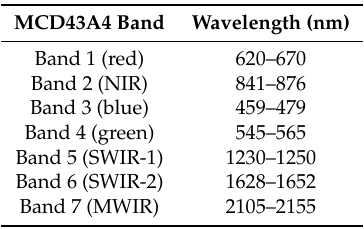
Table 1. Spectral specifications of the MODIS MCD43A4